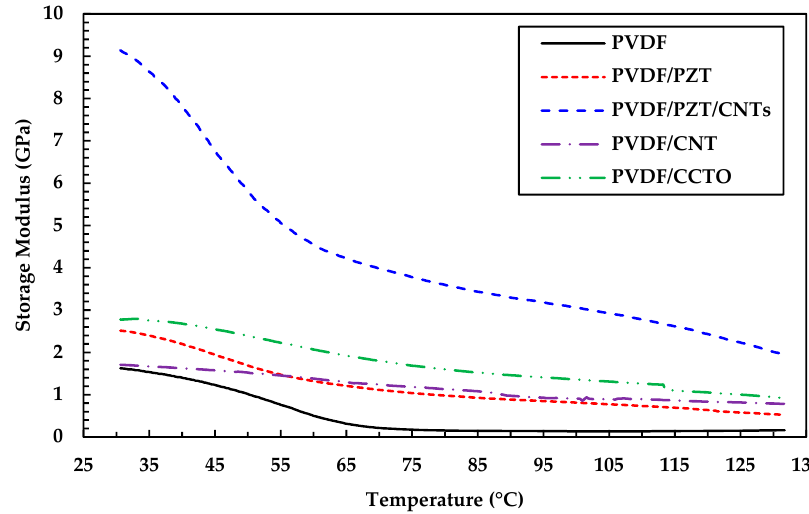
Figure 8. Storage modulus temperature sweep of PVDF polymer with different fillers at 1 Hz.